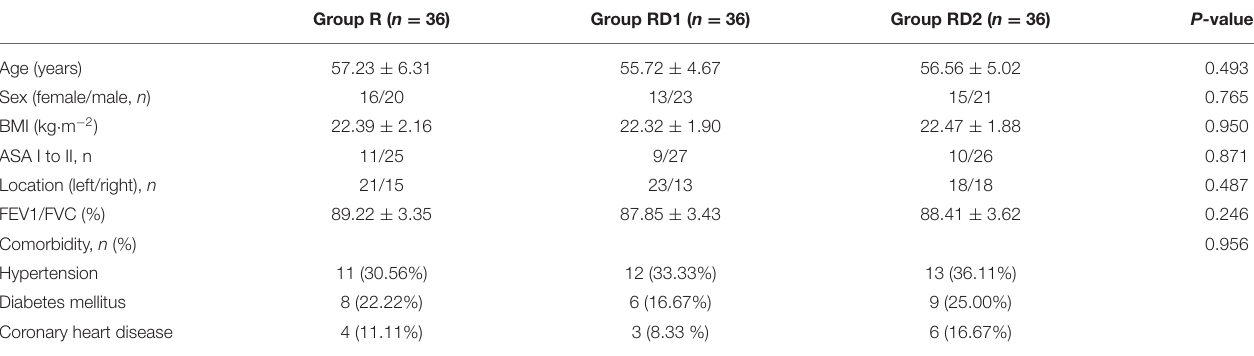
TABLE 1 | Demographic characteristics.